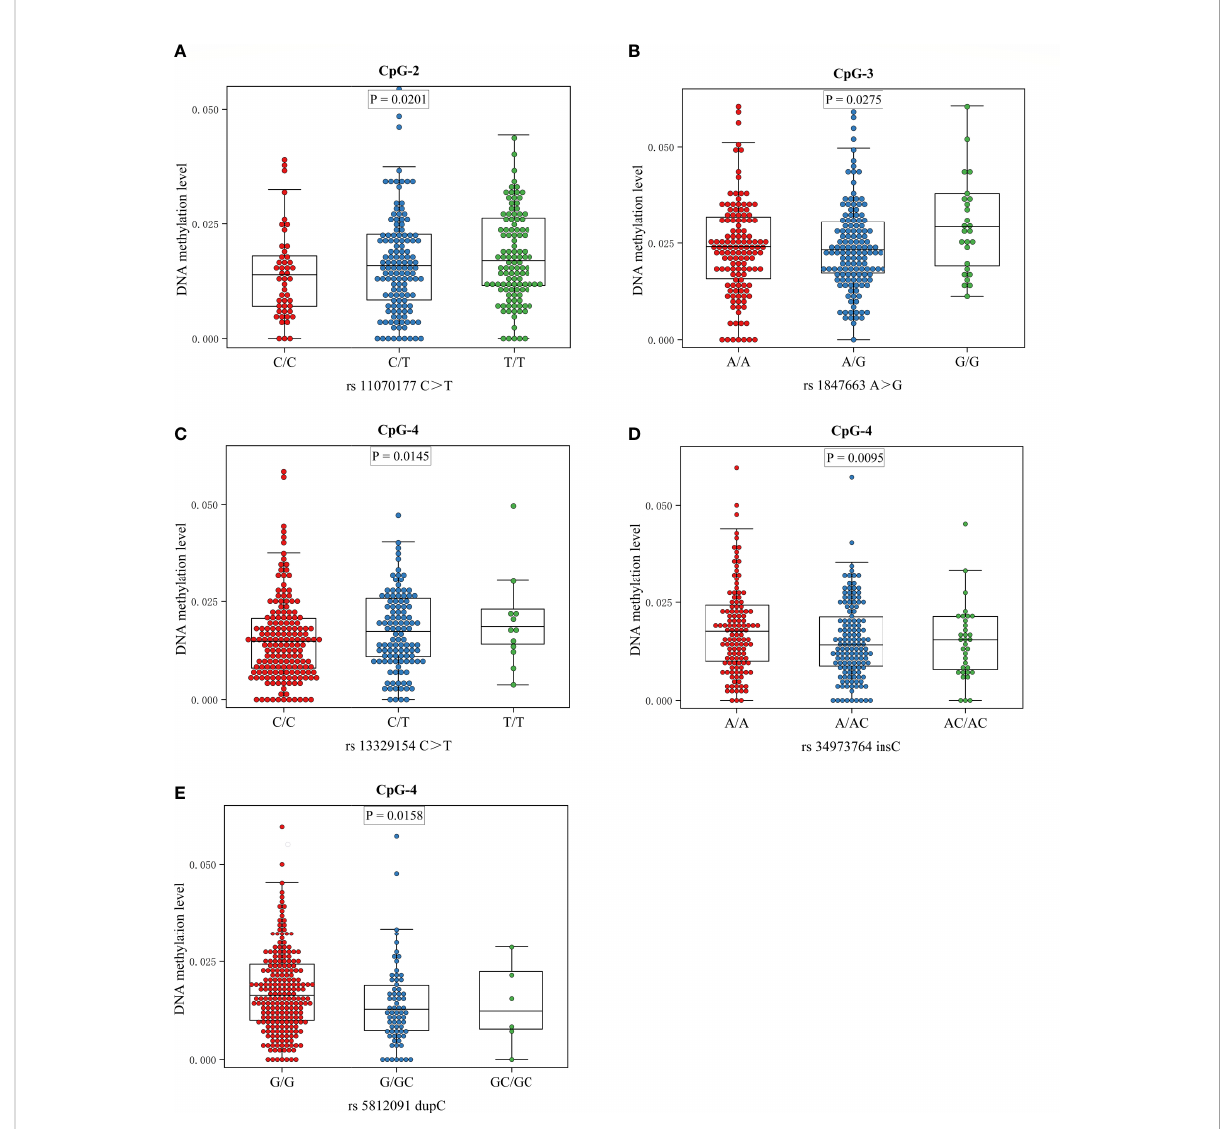
FIGURE 3 Boxplots showing methylation level plotted against genotypes for fi ve meQTLs: Center lines show the medians; box limits indicate the 25th and 75th percentiles; whiskers extend to the 5th and 95th percentiles. (A) The association between genotype at rs11070177 and methylation level at CpG-2; (B) the association between genotype at rs1847663 and methylation level at CpG-3; (C – E) the association between genotypes at rs13329154, rs34973764, rs5812091 and methylation level at